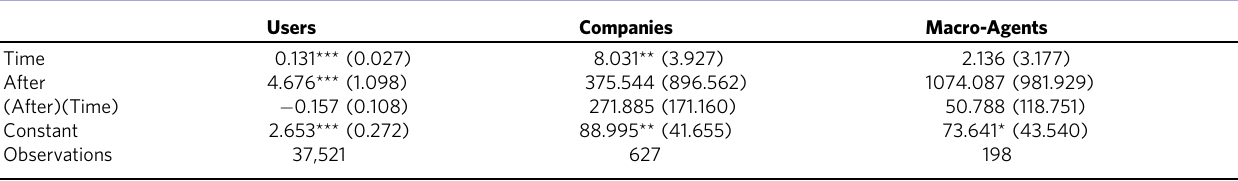
ThedependentvariableisthenumberoftransactionsperUsers,thenumberoftransactionperCompanies,andthenumberoftransactionsperMacro-Agents.InColumnUsers,thesampleperiodisfrom January2015toDecember2017andconvertedto90-daytimespans(from − 14to + 18).InColumnCompanies,thesampleperiodisfromJanuary2015toDecember2017andconvertedto90-daytime spans (from − 14 to + 18). In Column Macro-Agents, the sample period is from January 2015 to December 2017 and converted to 90-day time spans (from − 14 to + 18). Time span is 90-day time slices used to construct 90-day span network graphs. Time span 0 extends from 04-25-2016 to 05-24-2016 (i.e., the moment of the incentives policies). After is a dummy variable that equal 1 if time span is after the incentives policies and 0 otherwise. Newey-West robust standard errors are reported in brackets. *** p <0.01, ** p <0.05, * p